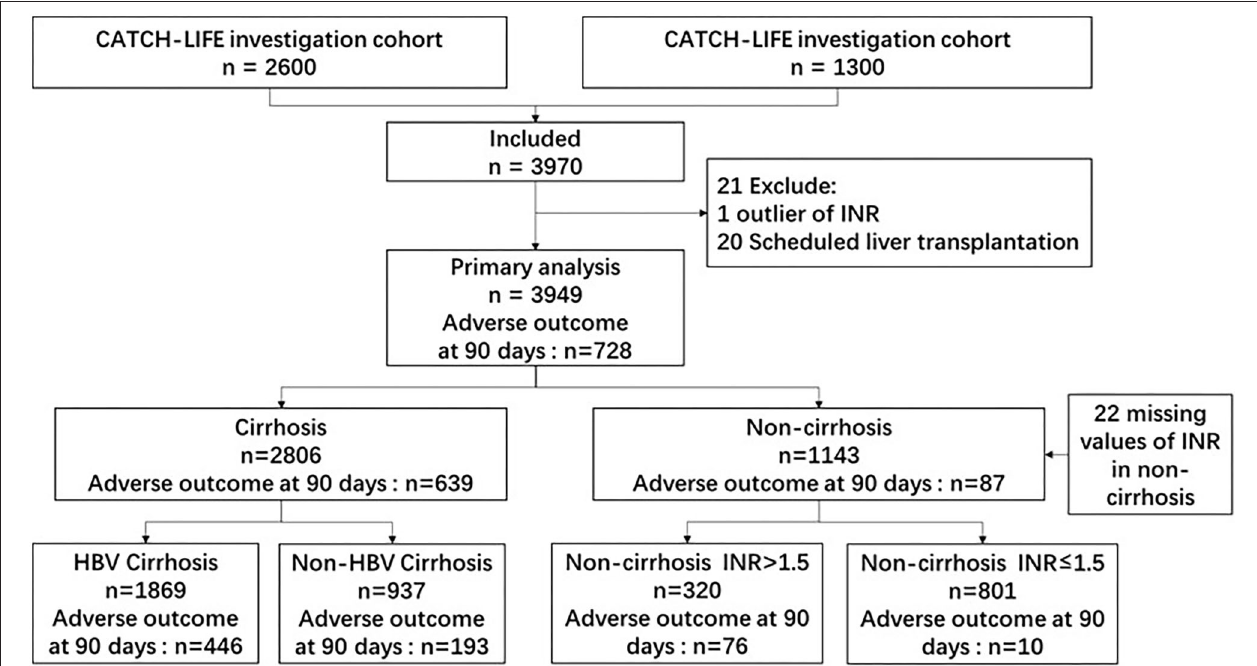
FIGURE 1 | Flow chart of patient recruitment. INR, international normalized ratio; HBV, hepatitis B virus.